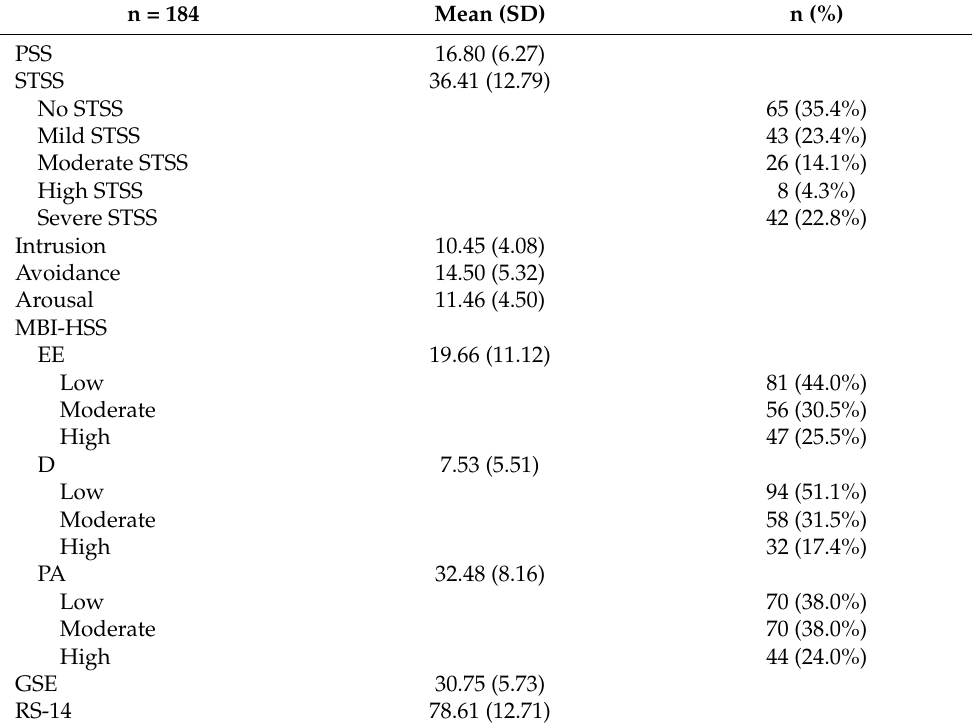
Table 3. Questionnaire scales and subscales scores and prevalence in total